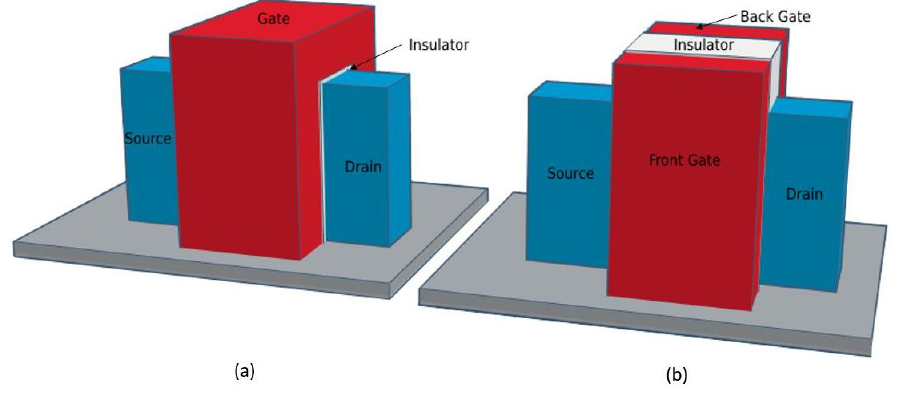
Figure 8. ( a ) Short-hate FinFET; and ( b ) independent-gate